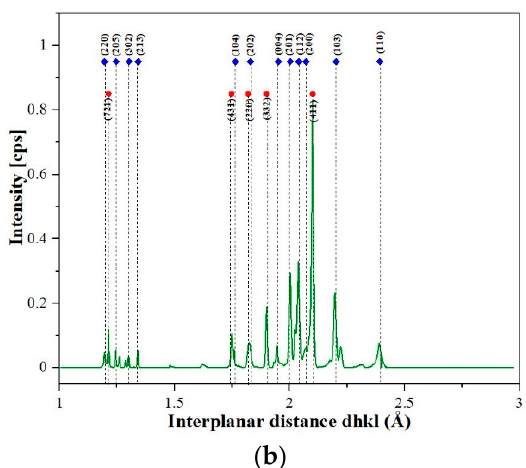
Figure 11. Exemplary diffractograms of TiCoCrFeMn alloy annealed during 100 h presented as a function of the interplanar distance d hkl ( a ) and the result of indicating the repetitive reflections ( b ).